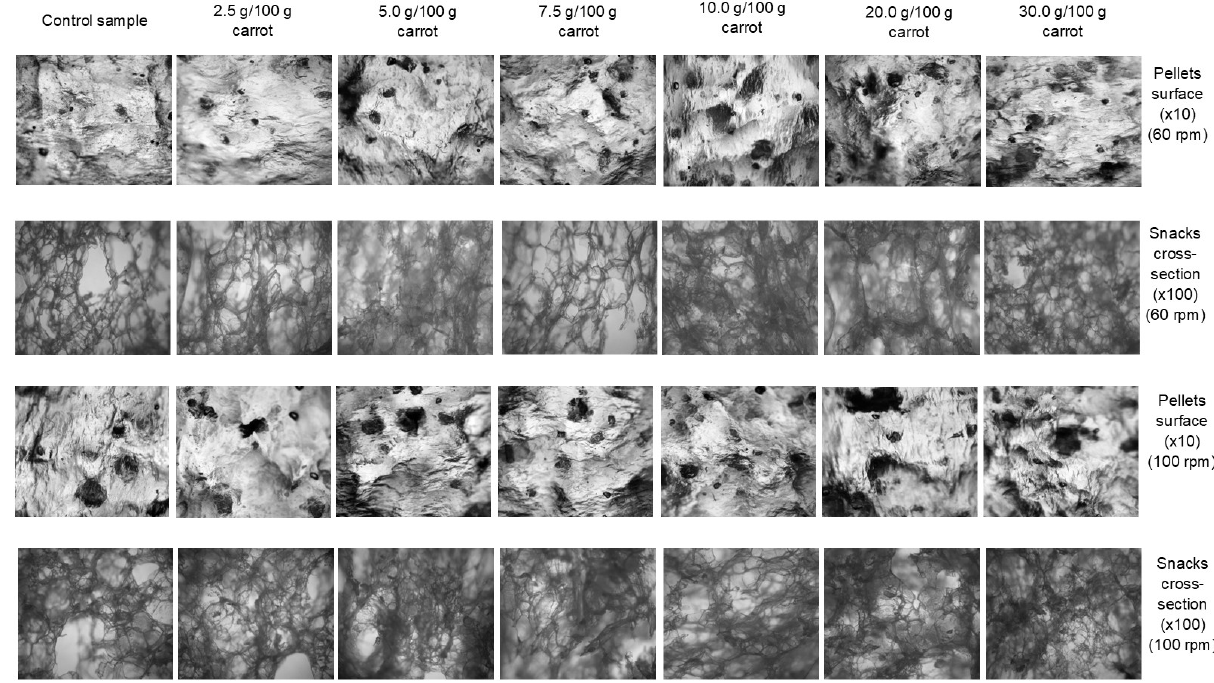
Figure 3. Microscopic structure of pellet and microwave-expanded snack surfaces ( × 10 magnification), and cross-section ( × 100 magnification). Herein, the structure depends on the content of the fresh carrot pulp addition (in columns) and screw speed during processing (in rows). Table 2. Physical properties of pellets and microwave-expanded snacks with the addition of fresh carrot pulp. Amount of Carrot (g/100